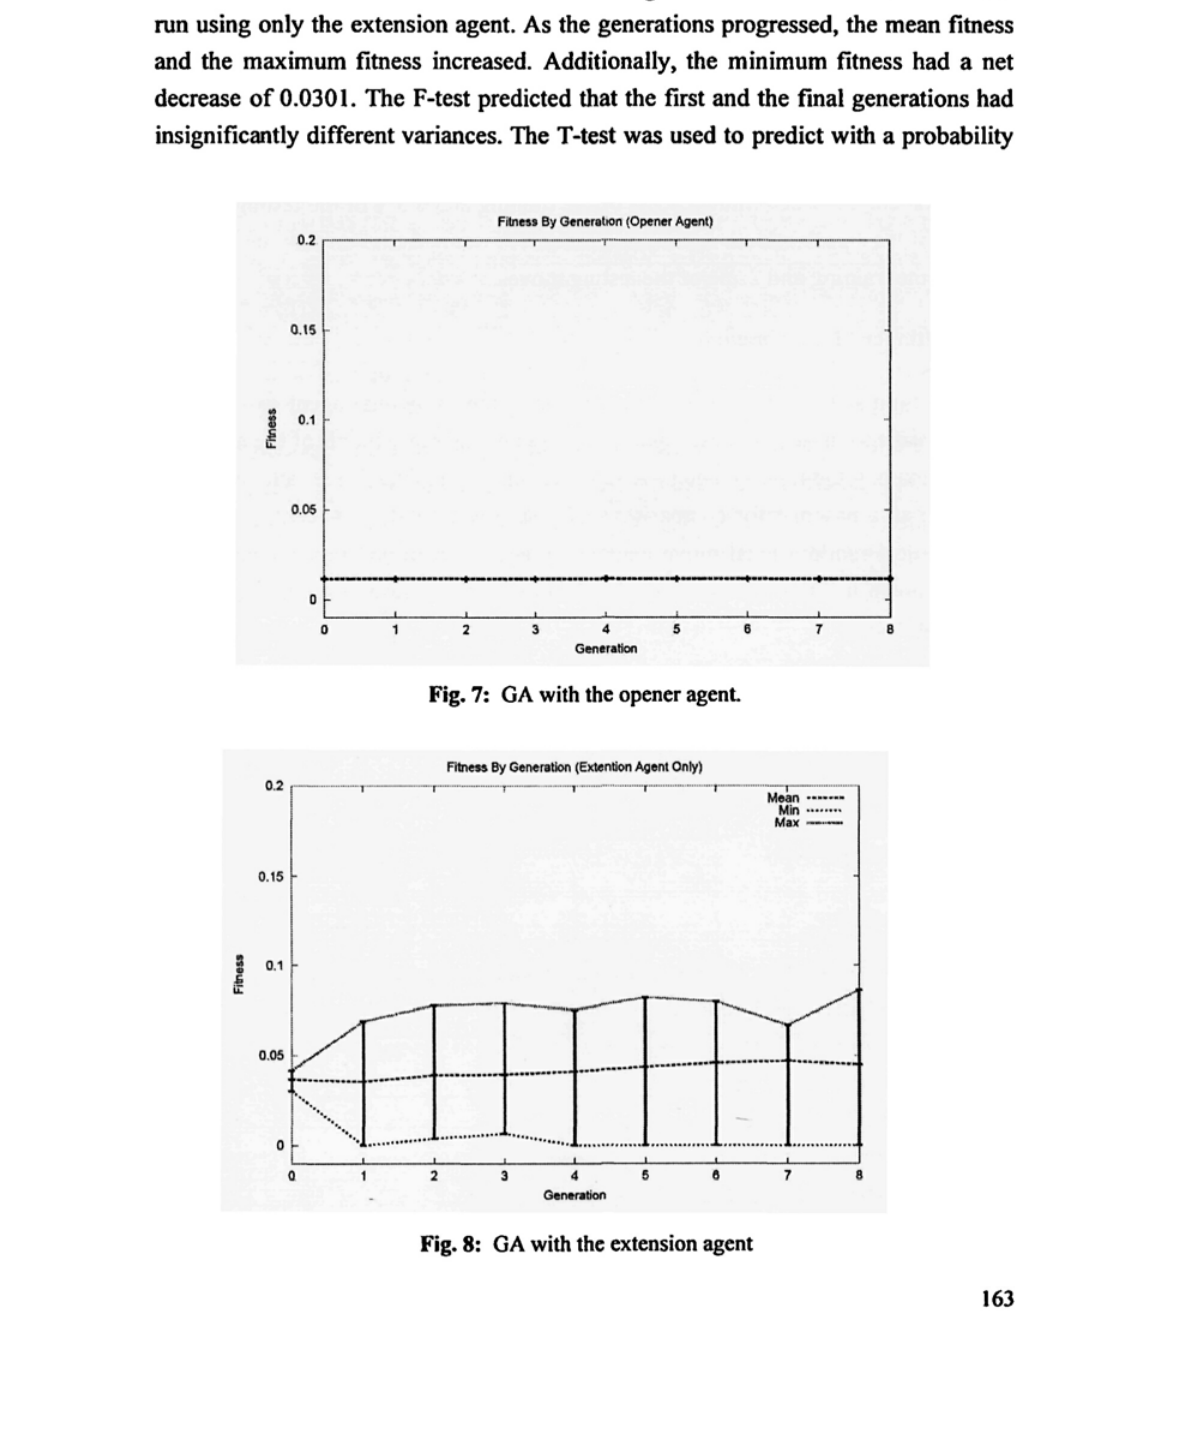
Fig. 8: GA with the extension